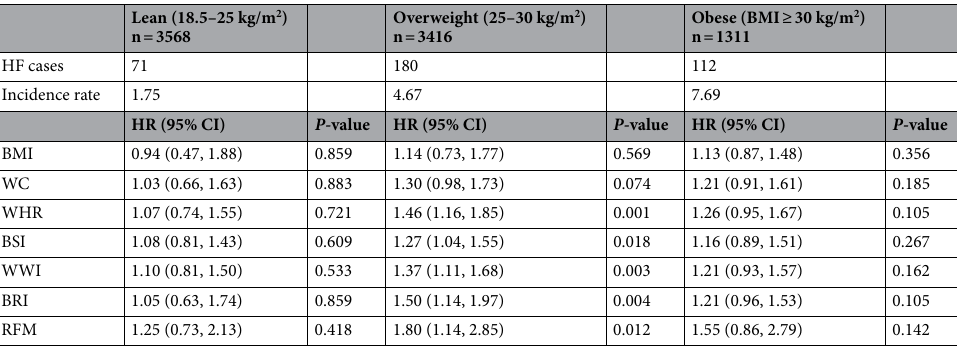
Table 4. Associations of adiposity indices with incident heart failure across body-mass index categories. Multivariable models were adjusted for age, sex, smoking, cholesterol, systolic blood pressure, glucose, and history of myocardial infarction, stroke and atrial fibrillation. Abbreviations same as in Table 2.